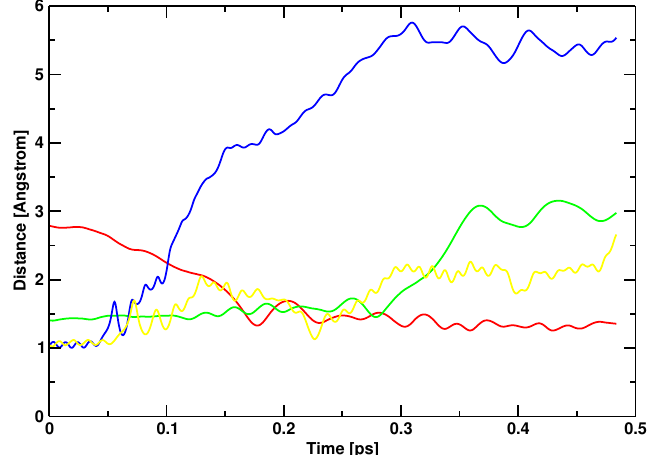
Figure 11. Formation of 3f : Change of distances with time, compare to Figure 10. Blue, green and yellow: bonds that are broken. Red: bond that is formed.